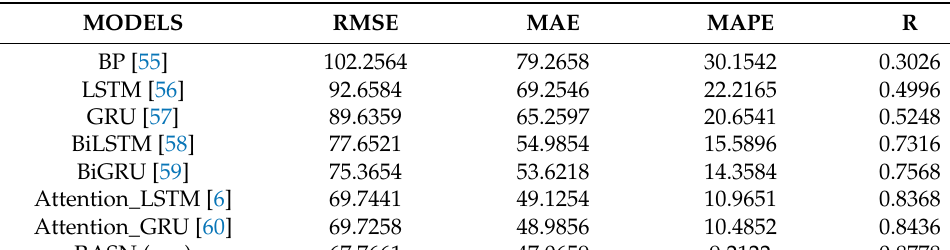
Table 4. Comparison of model prediction performance based on CO 2 data.